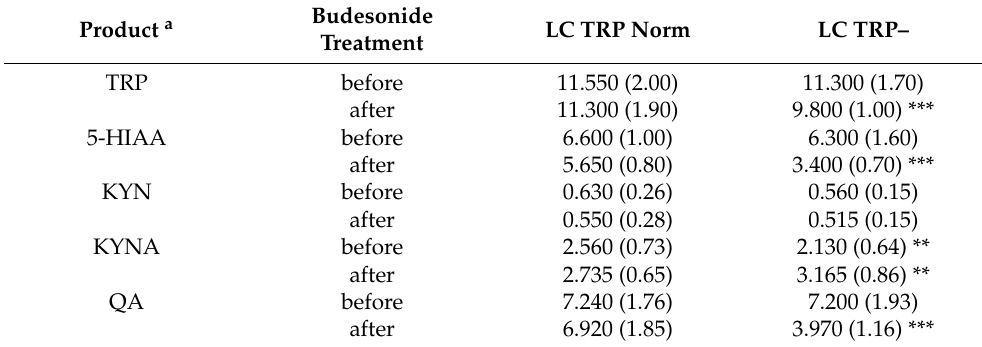
Table 4. Concentration of tryptophan (TRP) and main products of its metabolism in the kynurenine pathway in urine of LC patients treated for 8 weeks with budesonide at 9 mg daily without or with dietary intervention with reduced TRP (LC TRP norm and LC TRP–, respectively; n = 30 in each group) before and after budesonide